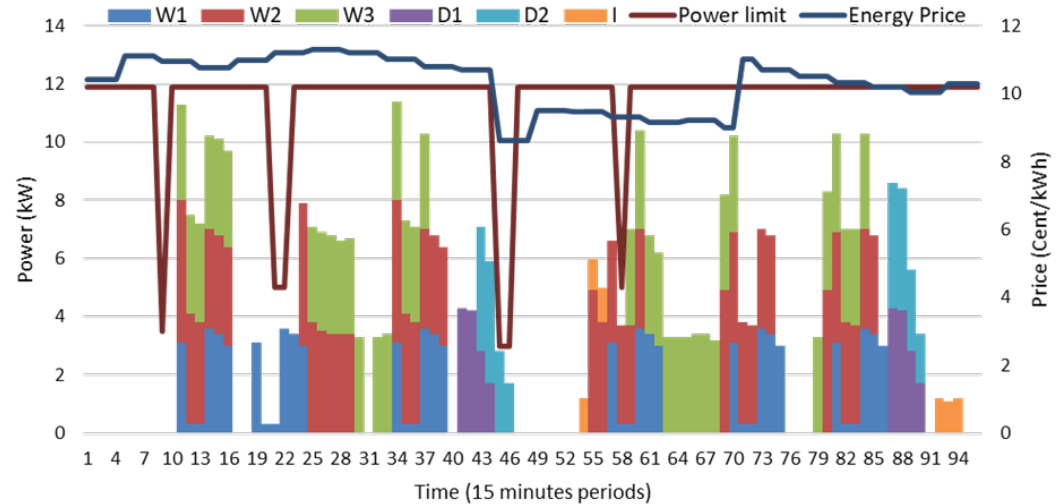
Figure 10. Power consumption of devices in scenario F (considering incentive and power consumption limit).